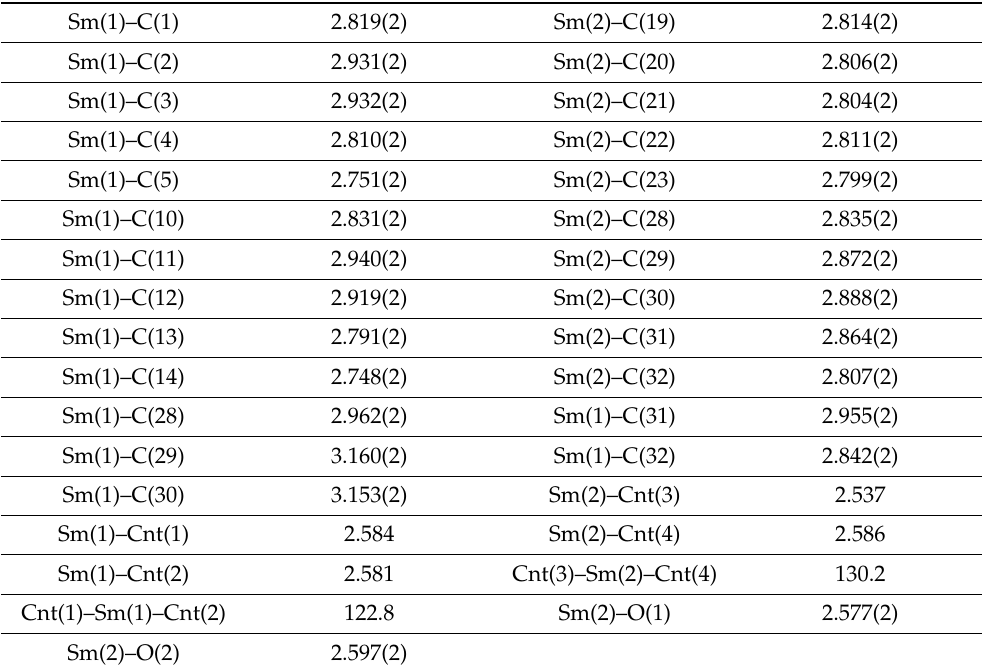
Table 3. Selected bond distances (Å) and angles ( ◦ ) for (C 5 Me 4 H) 2 Sm( µ - η 3 : η 5 -C 5 Me 4 H)Sm (C 5 Me 4 H)(THF) 2 , 3